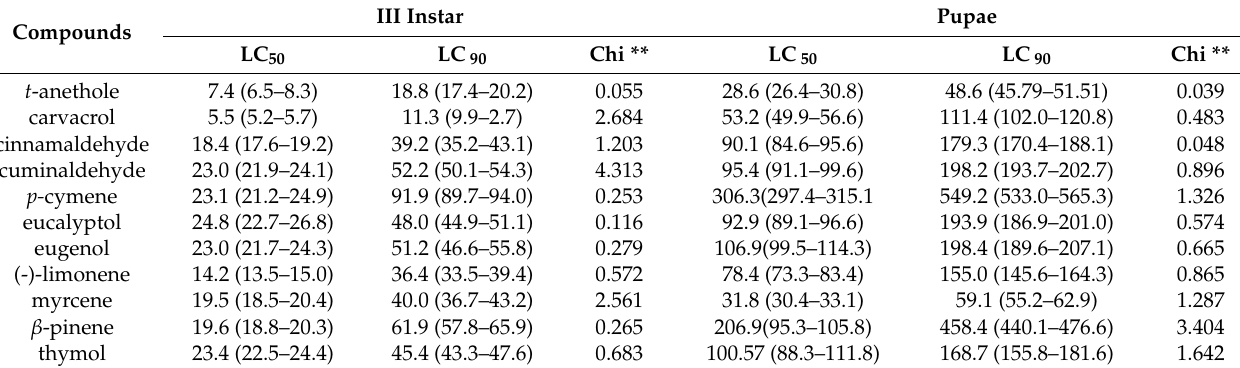
Table 3. LC 50 and LC 90 ( µ g/mL) of the major constituents of the essential oils at III instar and pupal of Culex quinquefasciatus after 24 h of